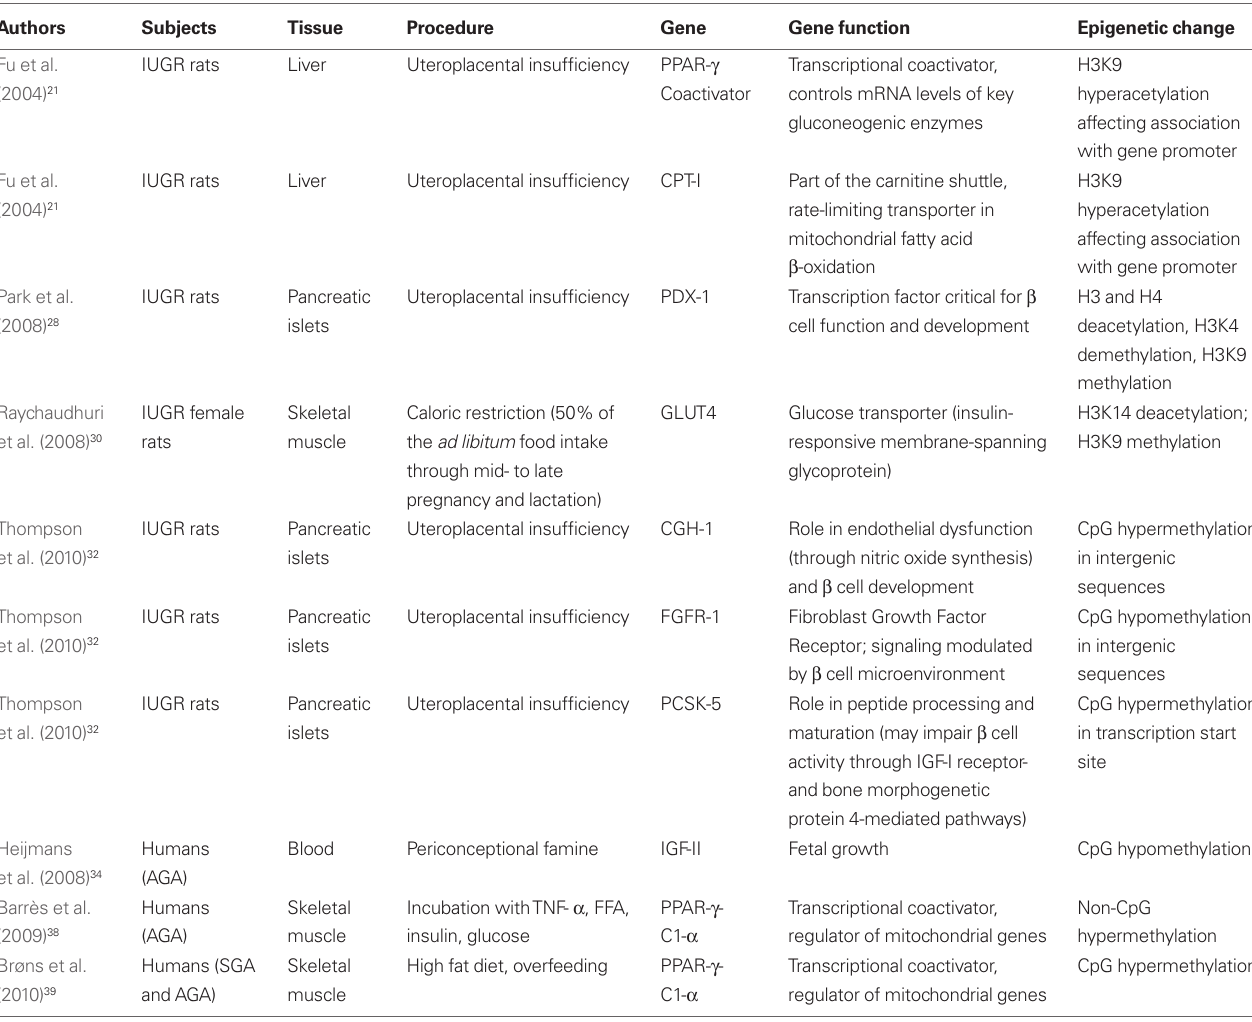
Table 1 | The different genes whose function is linked to the development of type 2 diabetes (and its complications).